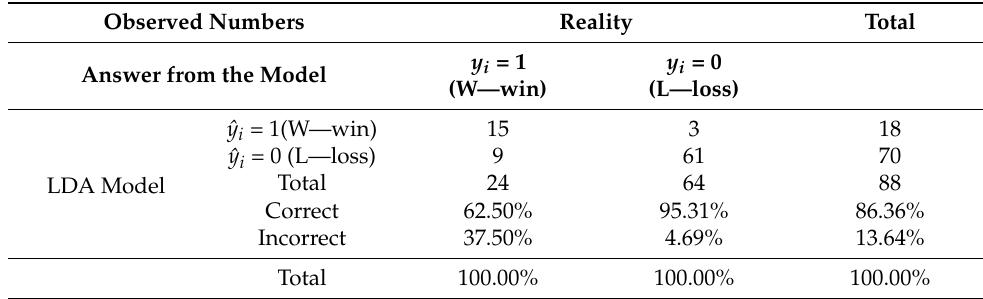
Table 10. Summary of classification for the LDA model.